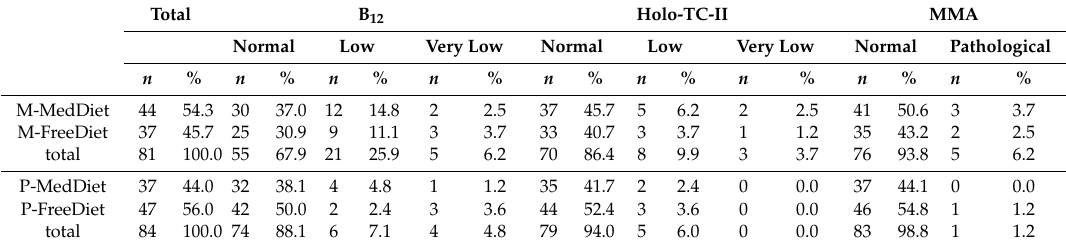
Table 2. Frequency distribution of B 12 deficit status at T1 according to World Health Organization WHO guidelines, for each treatment